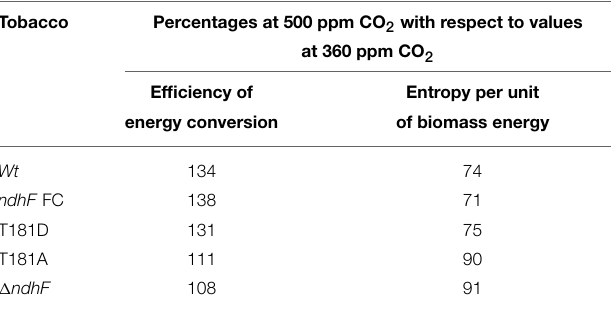
TABLE 2 | Effect of ndh gene deficiency on the photosynthetic efficiency and the entropy production at high CO 2 concentrations.